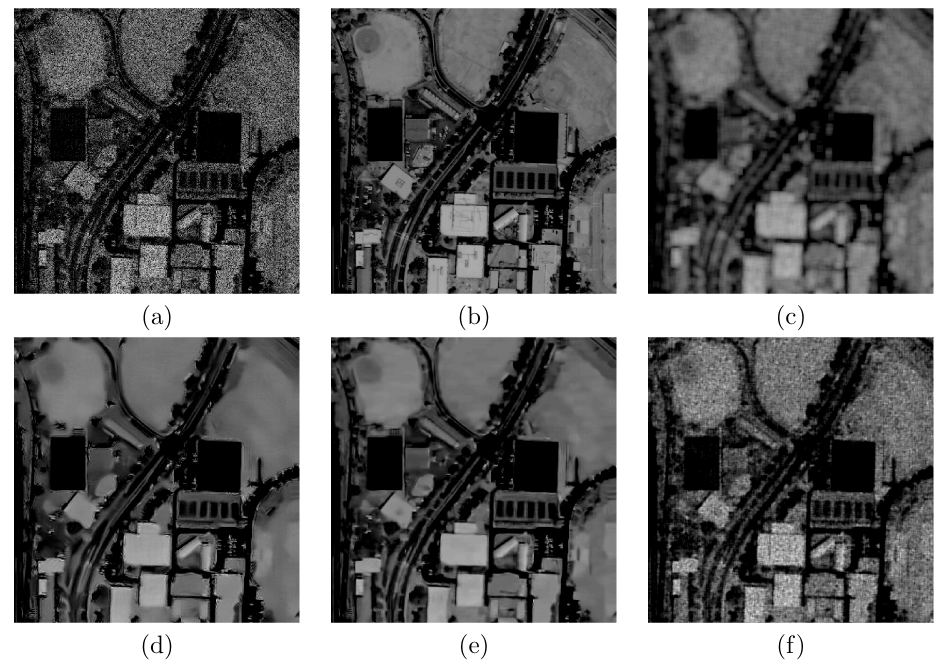
Figure 7. Rome test case: visual comparison between: ( a ) noisy image, ( b ) clean, ( c ) Kuan, ( d ) PPB-it, ( e ) FANS, and ( f ) EWF.